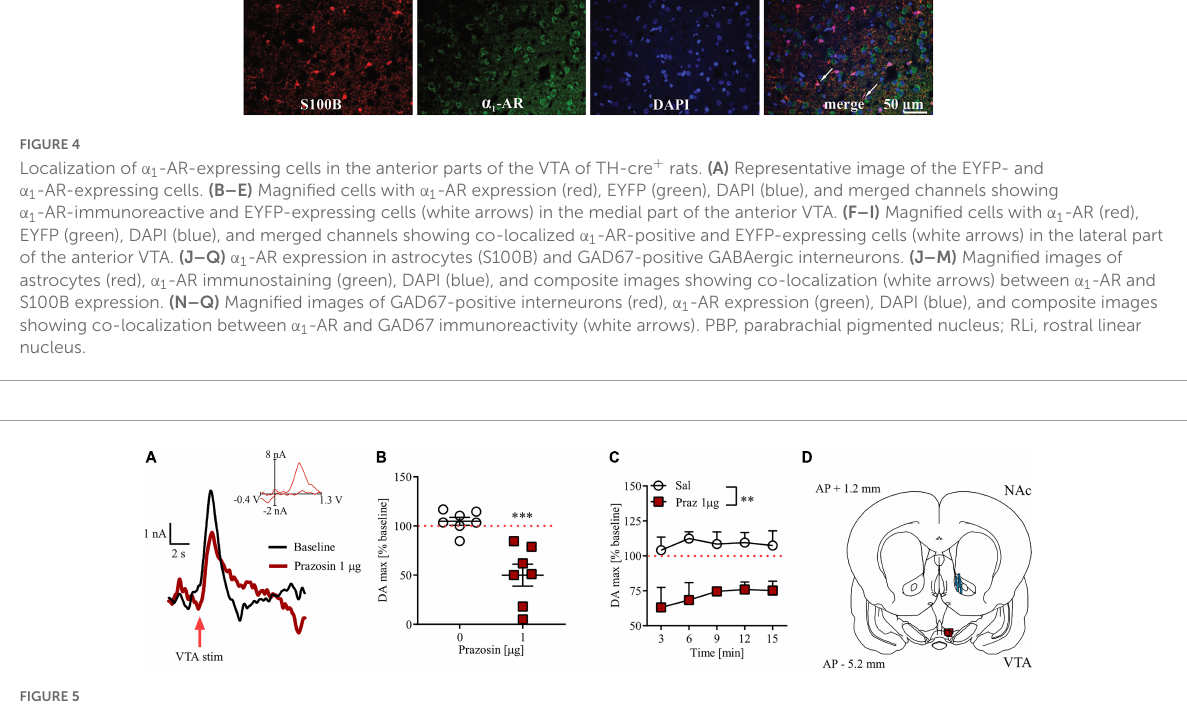
FIGURE5 Effects of prazosin (Praz) on electrically evoked phasic dopamine release in the NAc core. (A) Representative FSCV traces obtained after intra-VTA infusion of saline (baseline) and 1.0 µ g prazosin. Insets show representative current to voltage traces. (B) Maximal effects (shown as% of their respective baseline) of intra-VTA administration of prazosin on DA release in the NAc core shown as relative DA at the time point at which highest mean difference was observed. (C) Time course of relative DA peaks over five consecutive measurements after saline (Sal) and 1.0 µ g Prazosin. (D) Localization of histologically verified cannula and FSCV electrode placements. ∗∗ p < 0.01, ∗∗∗ p < 0.001. Stimulation (stim). Data are shown as (B) individual data points and/or (B,C) mean ±